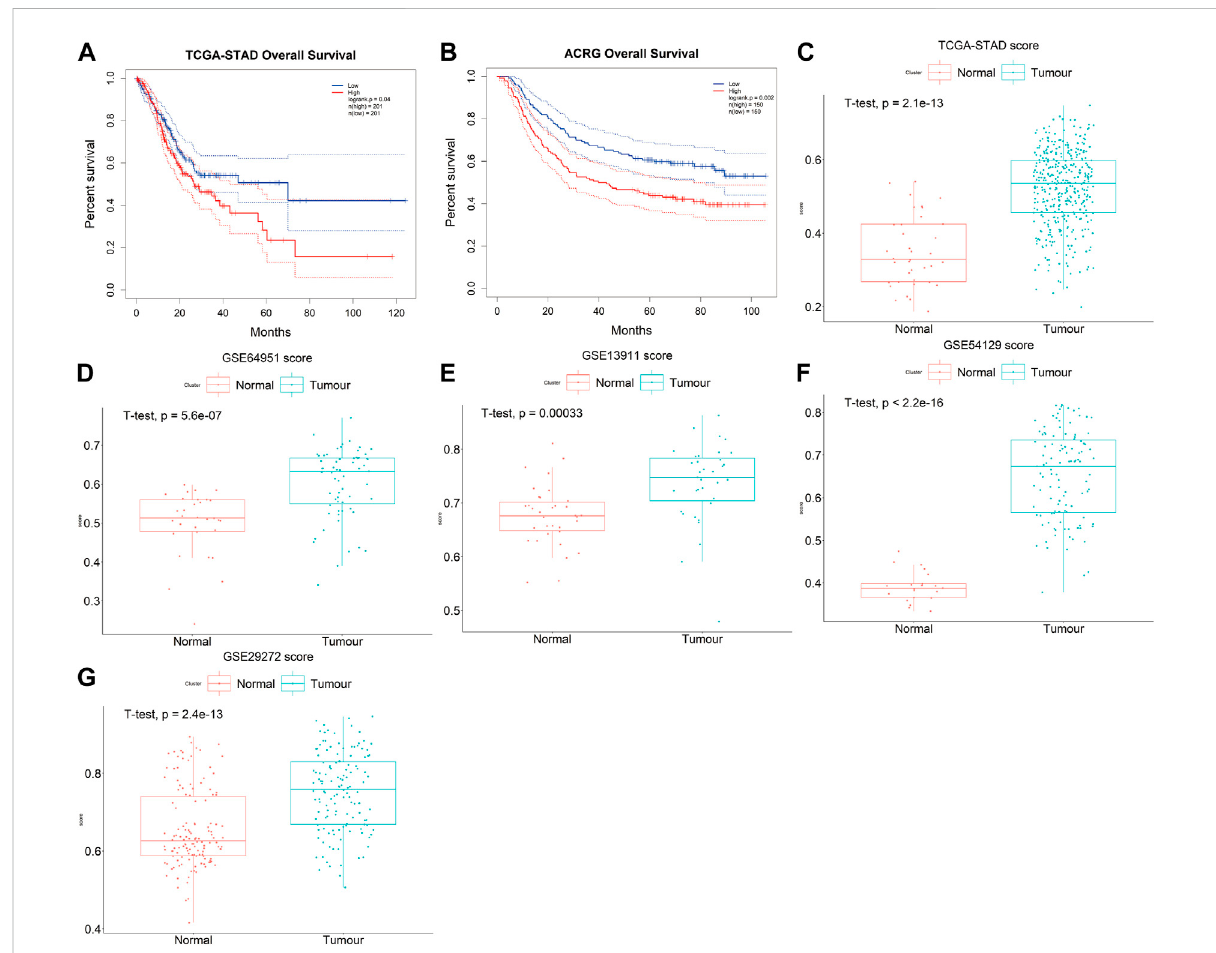
FIGURE 5 The PrognosisScore mode has strong robustness in predicting prognosis. (A,B) Survival analyses for low- and high-PrognosisScore groups usingKaplan-Meiercurves(Log-rank test)in (A) TCGA-STADand (B) ACRGdata cohorts; (C – G) TheboxplotofPrognosisScore intumorand normal group. (C) TCGA-STAD, (D) GSE64951 (ACRG), (E) GSE13911 (F) GSE54129, and (G) GSE29272. The thick line represented the median value. The bottom and top of the boxes are the 25th and 75th percentiles (interquartile range),